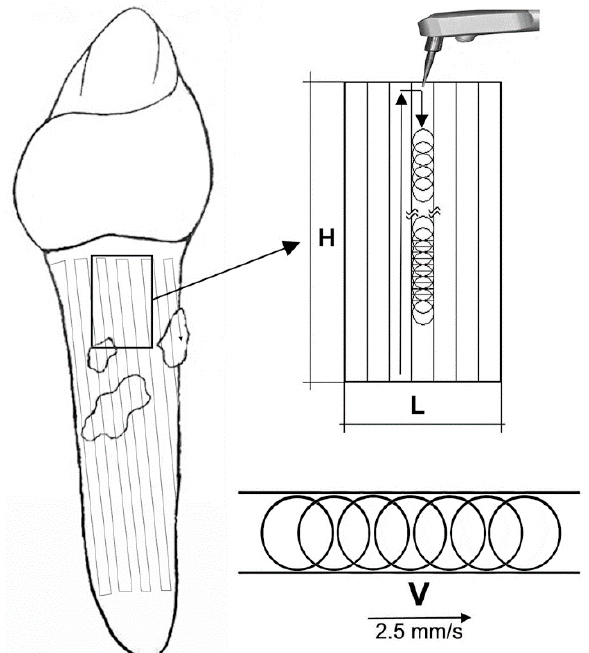
Figure 4. Graphic representation of the treated root surface during a photoablative treatment. Correct photoablation results from a succession of adjacent, non-overlapped lines covering the whole surface area under treatment. Accordingly, the total time of the treatment Tt is given by the following formula: Tt = N × Ts = N × 1 S where S is the constant speed of the laser spot, N is the number of lines, and Ts is the time required to treat a line.